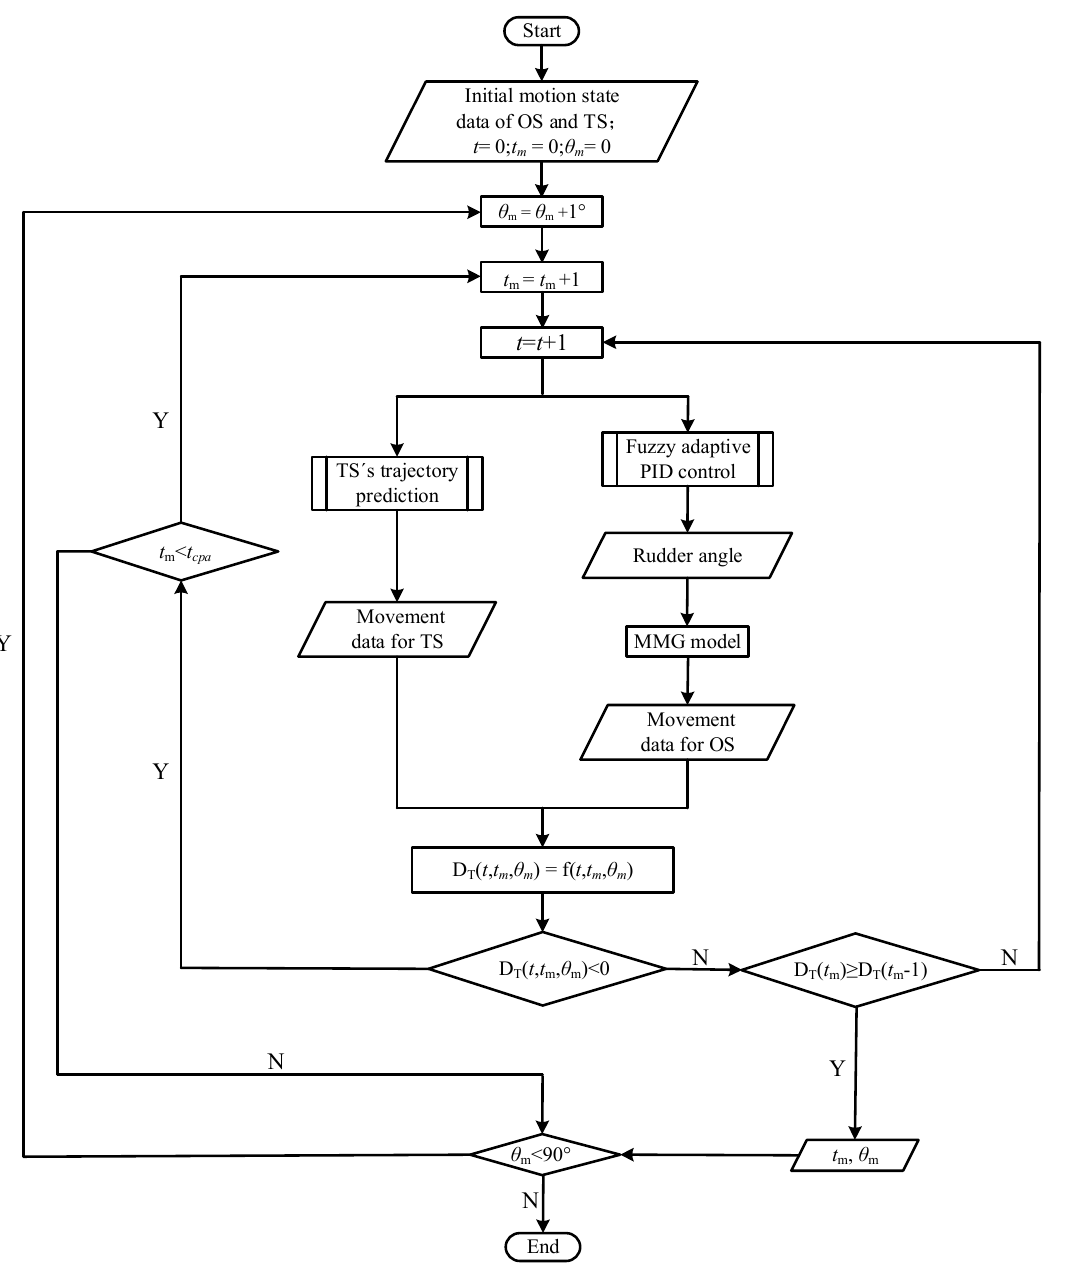
Figure 8. Numerical method of the latest steering time based on the course-alteration angle.